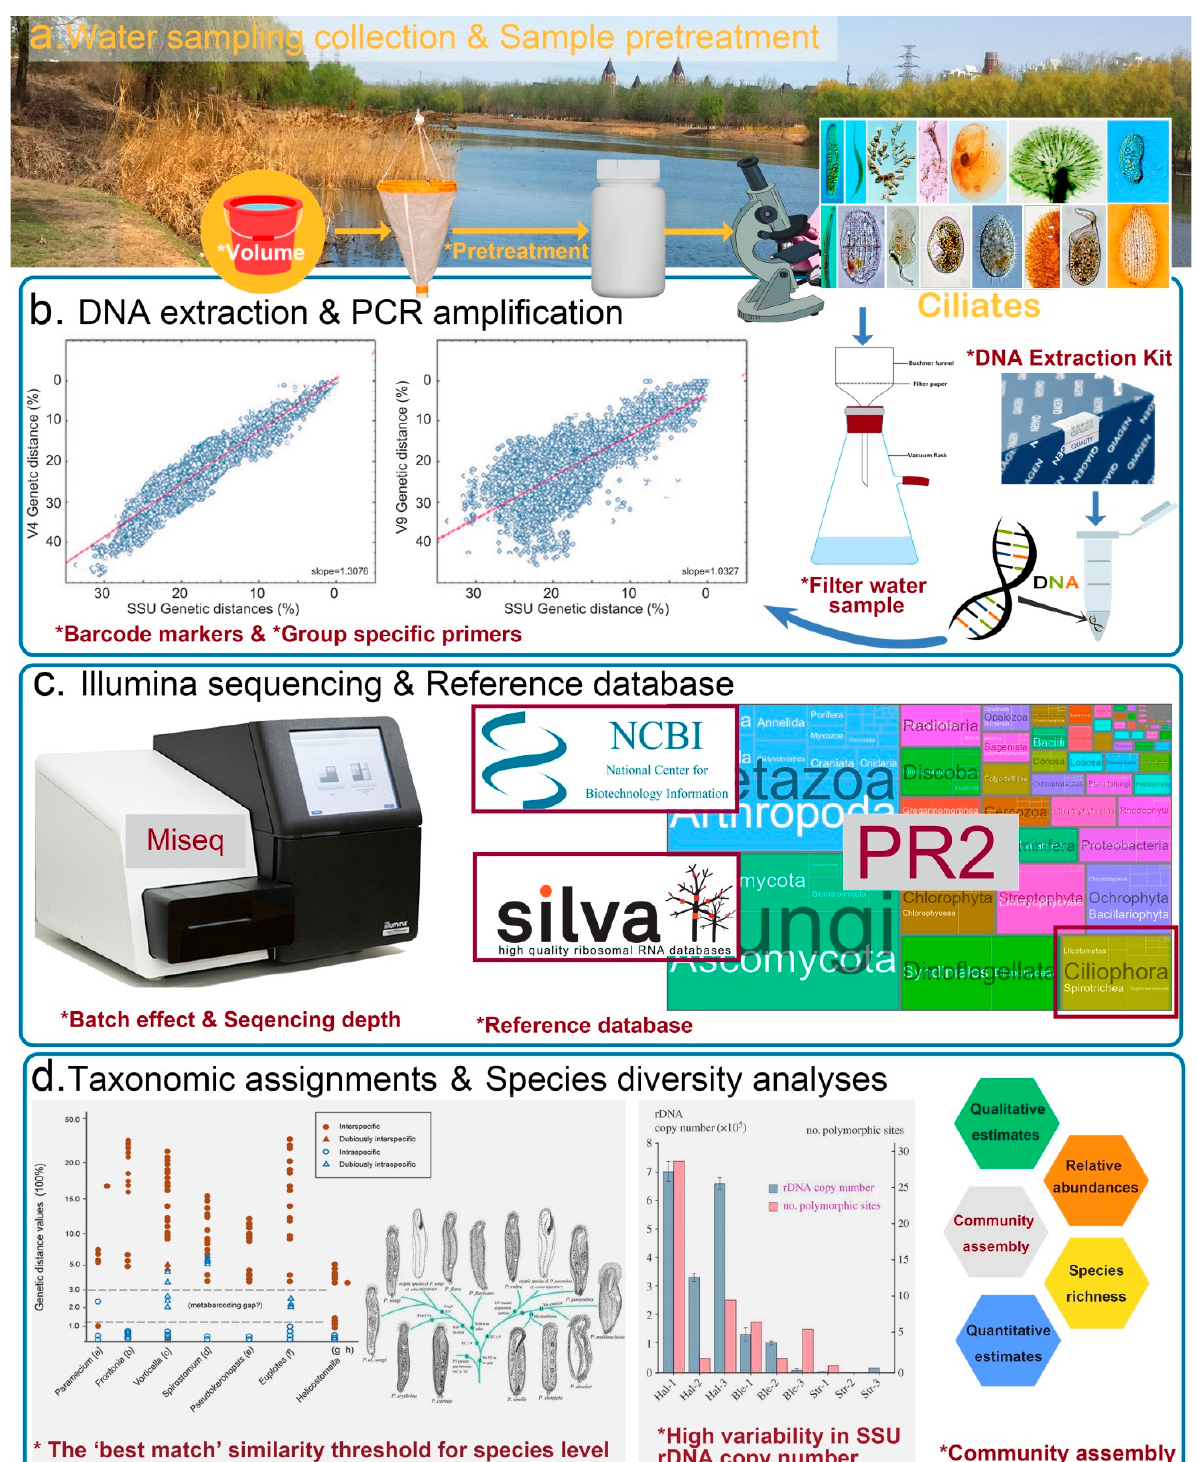
Figure 1. The flow chart of the metabarcoding processing steps (water sampling collection, sample pretreatment, DNA extraction, and PCR amplification, NGS-Illumina sequencing for example, reference database selection, and taxonomic assignment) of ciliate biodiversity. Factors that might distort biodiversity assessments are marked with an asterisk. The interior pictures in terms of “Barcode markers & Group specific primers”, “The ‘best match’ similarity threshold for species level” and “High variability in SSU rDNA copy number” are modified after the work of Dunthorn et al. [55] and Zhan et al. [70] and Wang et al.